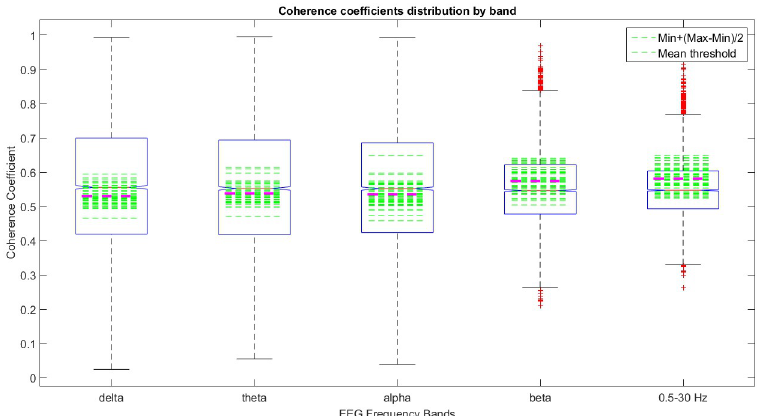
Fig 5. An example of the coherence coefficients distribution in all frequency bands. The green lines represent the proposed threshold per subject, which lie inside the 2nd and 3rd quartiles for δ , θ and α frequency bands, taking into account more or less the 50% of the coherence values sample. For β and 0.5 − 30 Hz frequency bands there are some thresholds outside the blue box which lie inside the 4th quartile taking into account less than the 25% of the coherence values sample. The magenta dashed line indicates the mean value of thresholds among the